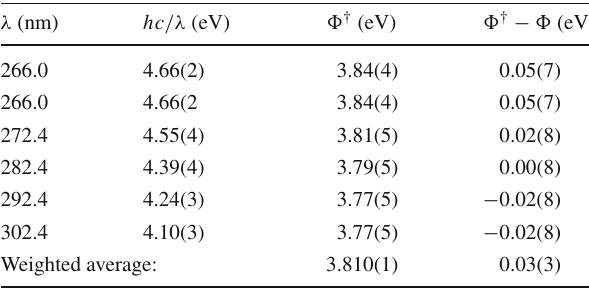
Table 4 Work functions determined from measured transmission func- tions at different wavelengths λ (Fig. 7). The work functions (cid:7) † are derived from (19), with E lim the upper limit of the energy distribution (Table 1) and hc /λ the known photon energy. The results are com- pared with the work function (cid:7) = 3 . 78 ( 4 ) eV that was determined in